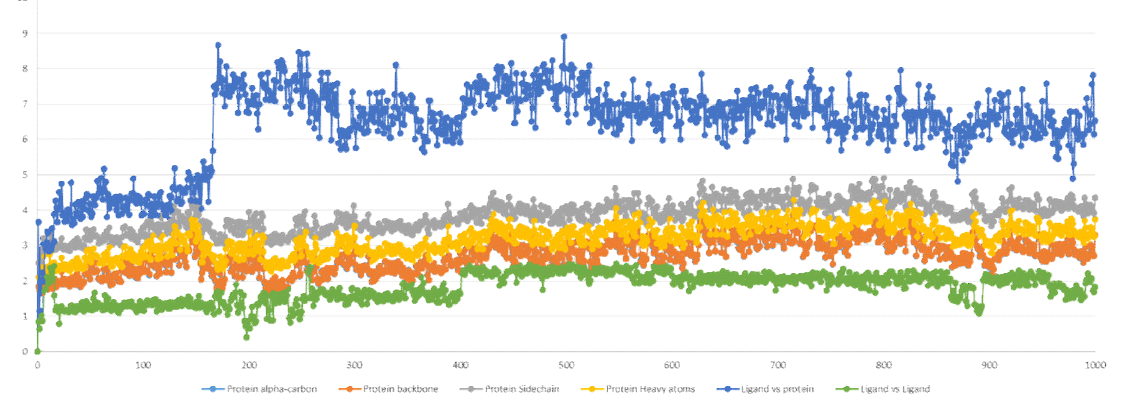
Figure 5. Compound 2C and protein RMSD during MD simulation (100 ns). The x -axis is ex- pressed by the number of snapshots extracted, and 1 snapshot = 100 ps; the y -axis is expressed in Å.